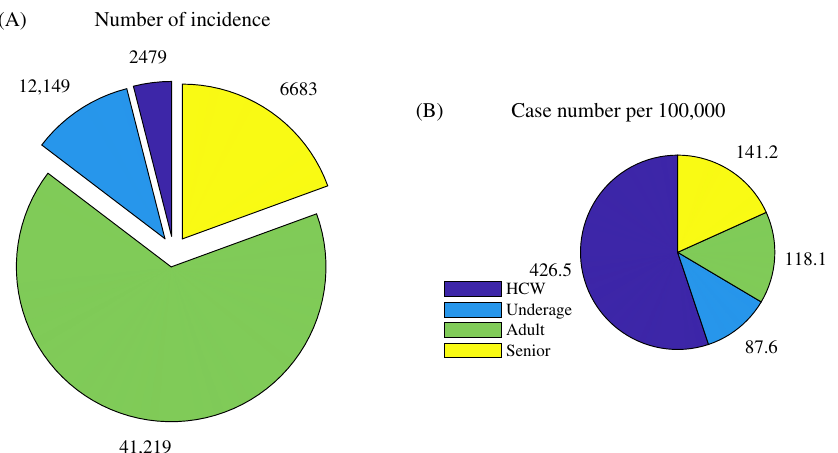
Figure 6. Confirmed case number of groups ( A ), and population-adjusted case number per 100,000 ( B ). Purple, blue, green, and yellow denote the HCW, underage, adult, and senior groups,